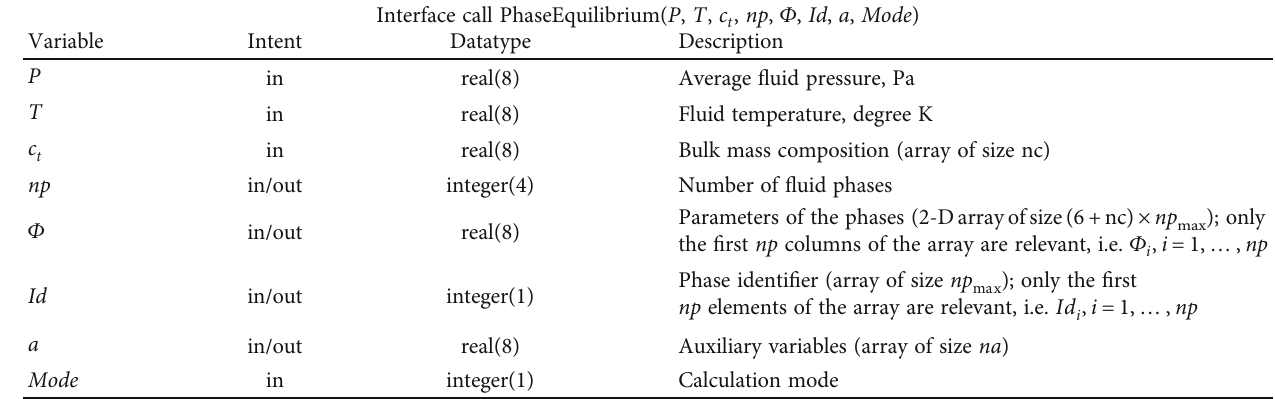
Table 4: API for PhaseEquilibrium